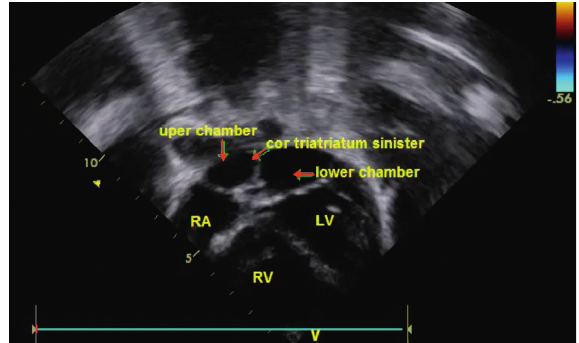
Figure 1: TTE demonstrating the left atrium expansion which has a fibromuscular membrane which divides the left atrium into two chambers.